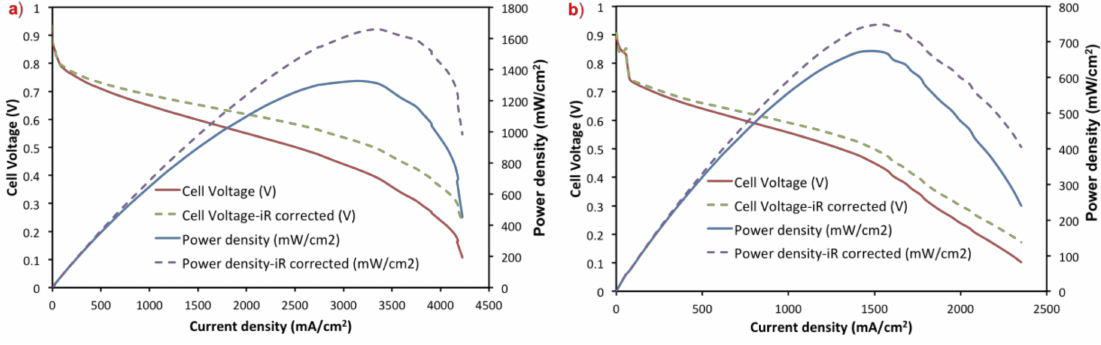
Figure 6. CF-VC anion exchange membrane fuel cell (AEMFC) polarization curves and power density in two configurations operated at 70 ◦ C. ( a ) H 2 -O 2 gases fed at 1 L/min, RH anode = 73%, RH cathode = 90% without backpressure; ( b ) H 2 -air (CO 2 -free) at 1 L/min; anode: 0.7 mg PtRu cm − 2 , RH = 76%, 0.03 Mpa backpressure; Cathode: 2.4 mg cm − 2 CF-VC, RH = 93%, 0.1 MPa backpressure., The membrane in this work was a polyethylene-based radiation-grafted anion exchange membrane (IEC = 2.44 ± 0.04 mmol g − 1 ) and the anionomer was ETFE-benzyltrimethylammonium (BTMA) powder [14] (IEC = 1.24 ± 0.06 mmol g − 1 ). (RH = relative